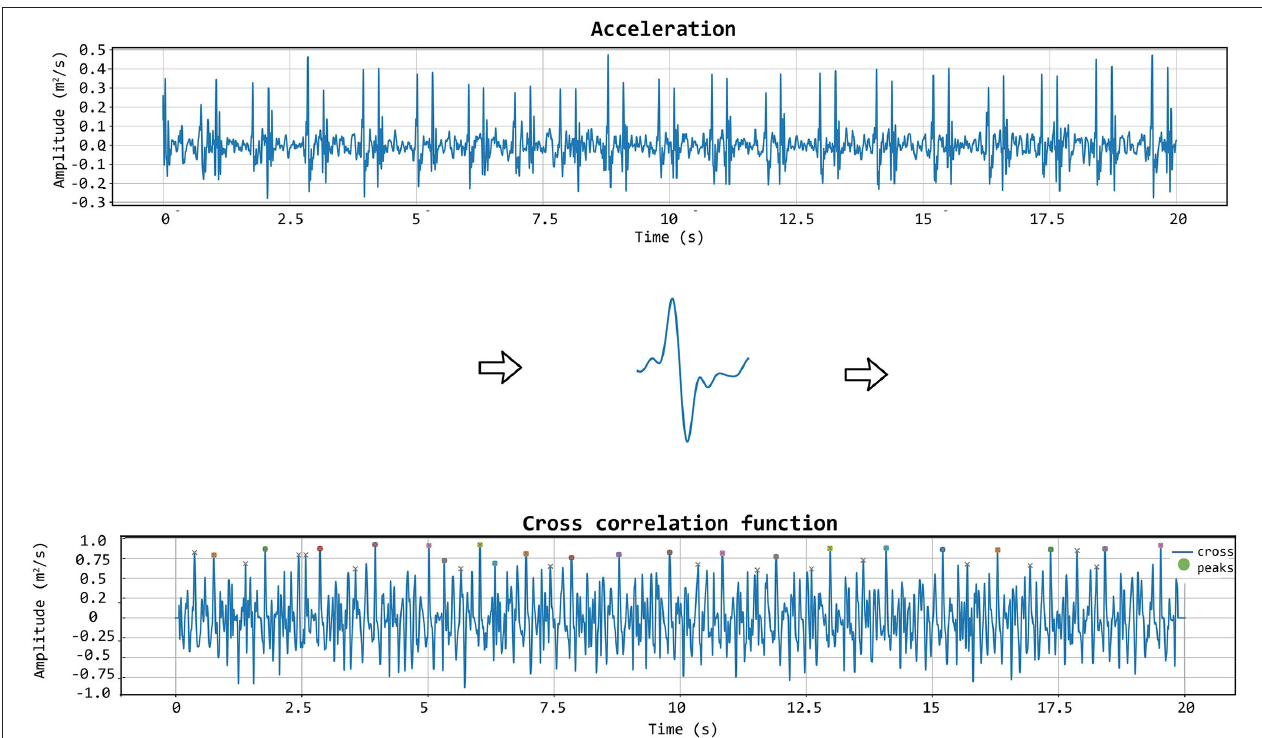
FIGURE 6 | The template matching algorithm is shown. The chosen template (displayed in the middle row of the figure) is iteratively correlated with the acceleration signal to get the cross-correlation function. In that function, the appropriate peaks are then